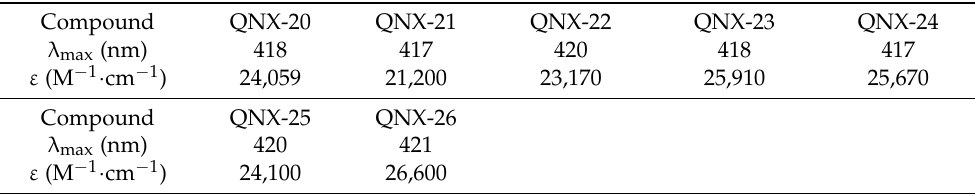
Figure 18. Chemical structures of 8-halogeno-5,12-dihydroquinoxalino[2,3- b ]quinoxalines QNX-20-QNX-26. Table 7. Optical characteristics of the QNX-20-QNX-26 series in 1-methyl-2-pyrrolidone.